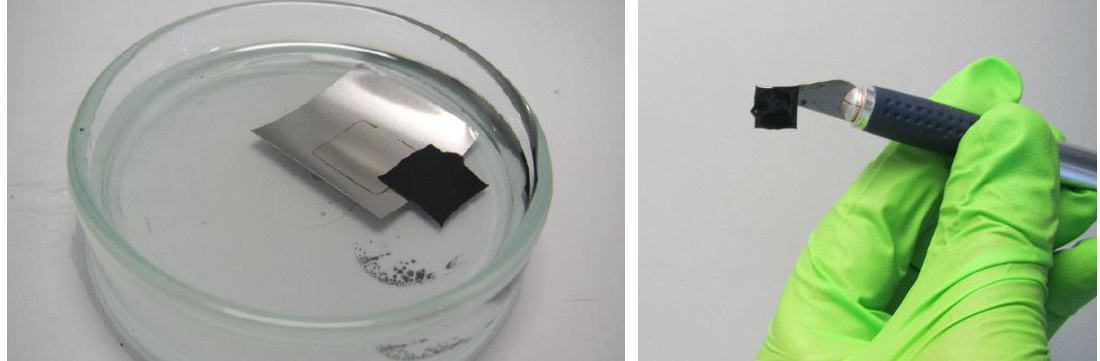
Figure 5. Peeling of the film from a metal surface (left) and the polymer film in a free form, without substrate (right).